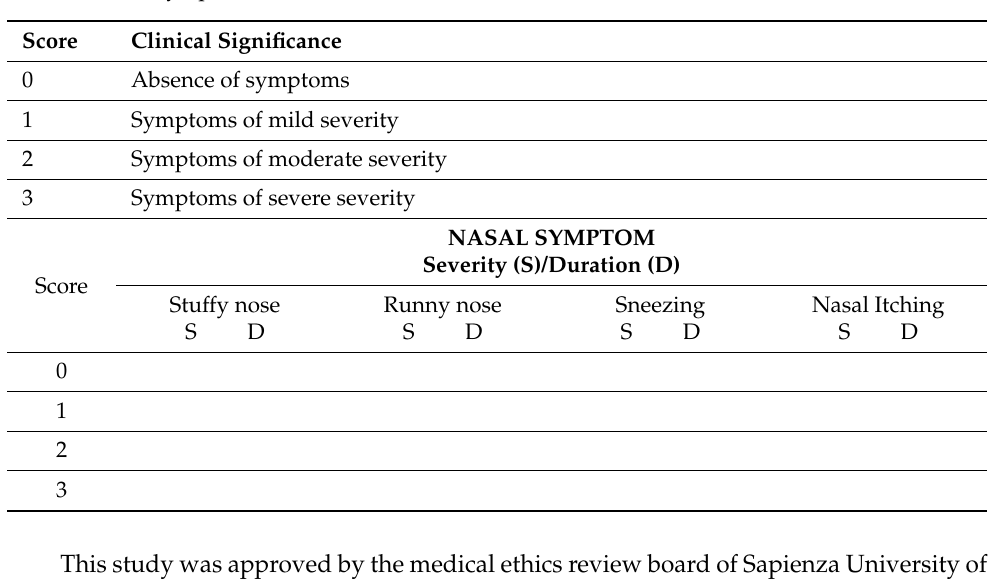
Table 2. Nasal Symptom Score Scale.